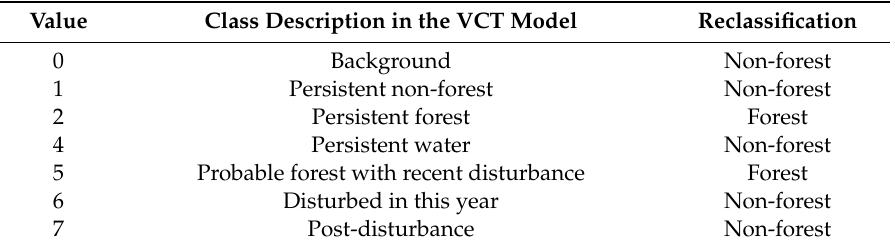
Table 3. Reclassification of the annual forest disturbance maps derived from the vegetation change tracker (VCT)